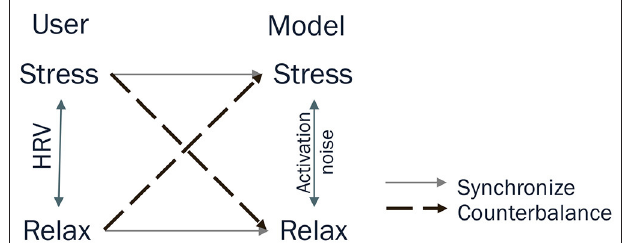
FIGURE 2 | Connection between a user and a cognitive model. The states of the user (left) and the model (model) are located along the vertical axes indicating the arousal level. High and low arousal levels correspond to stressed and relaxed situations, respectively. The heart rate variability (HRV) and the activation noise [ s in Equation (3)] represent the axis of the user and the model. The synchronize relation (horizontal arrows) directly connects these two variables, whereas the counterbalance relation (diagonal arrows) inverts HRV [Equation (7)] before connecting with the activation